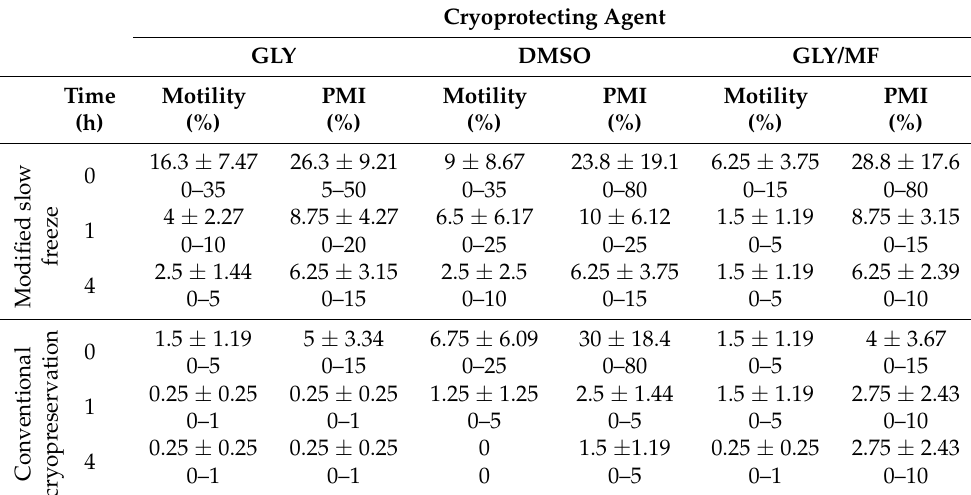
Table 3. Longitudinal post-thaw survival of southern stingray ( Hypanus americana ) sperm cryopre- served using various freezing methods and cryoprotecting agents ( x ± SEM, Range).